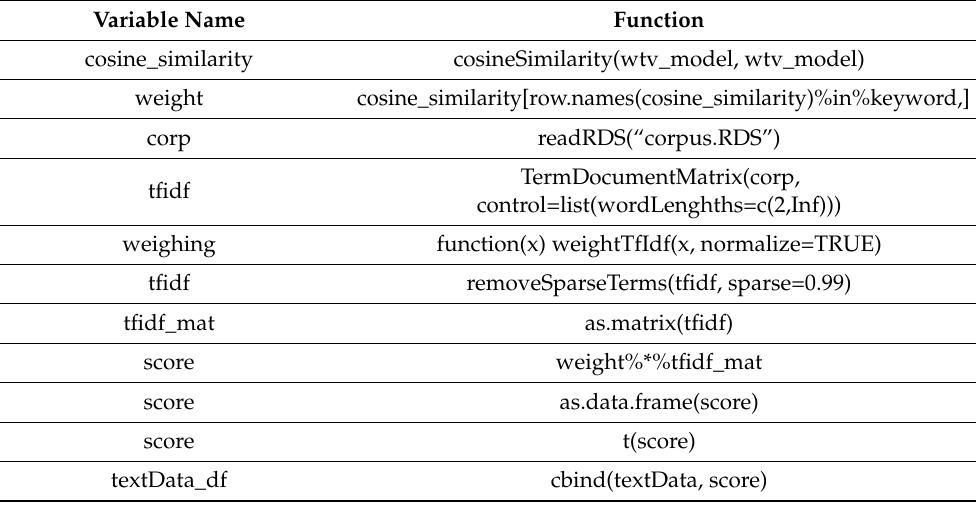
Table 1. Variable name and function of the code used for